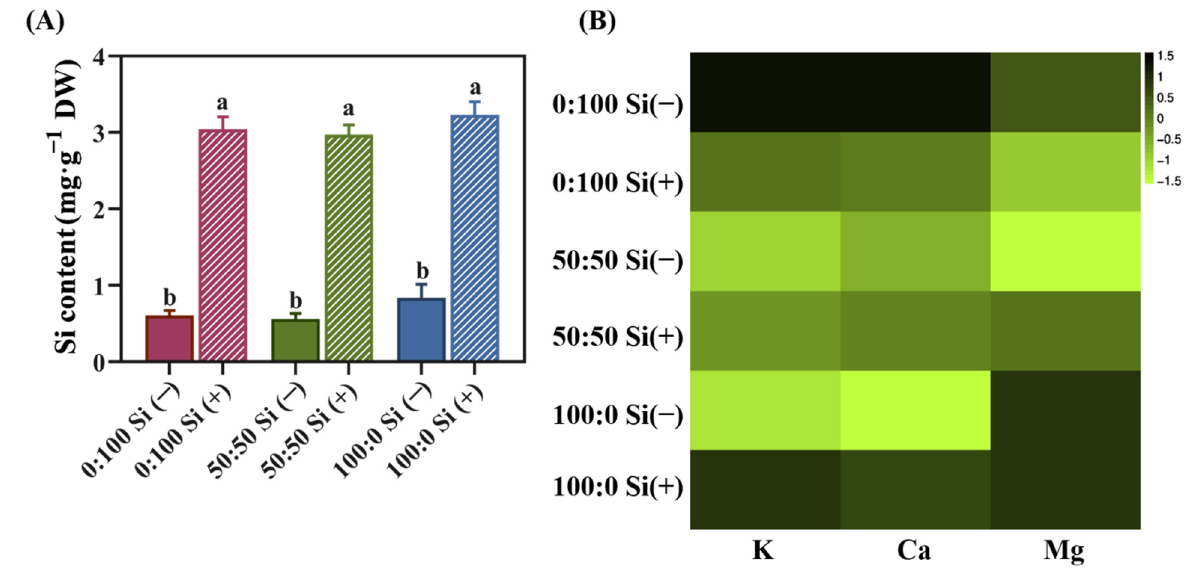
Figure 4. Si, K, Ca, and Mg contents in plants as affected by the N form with or without Si supple- mentation. ( A ) Si content in salvia plants subjected to different treatments; data are given as the mean ± standard deviation (SD) of n = 3 technical replicates. Significant differences are shown using different lowercase letters, which were determined using Duncan’s multiple range test at p = 0.05. ( B ) Concentrations of K, Ca, and Mg in plants were compared and illustrated via a heatmap; the original data was averaged, log2-normalized, and clustered following the criterion by Chen [42].